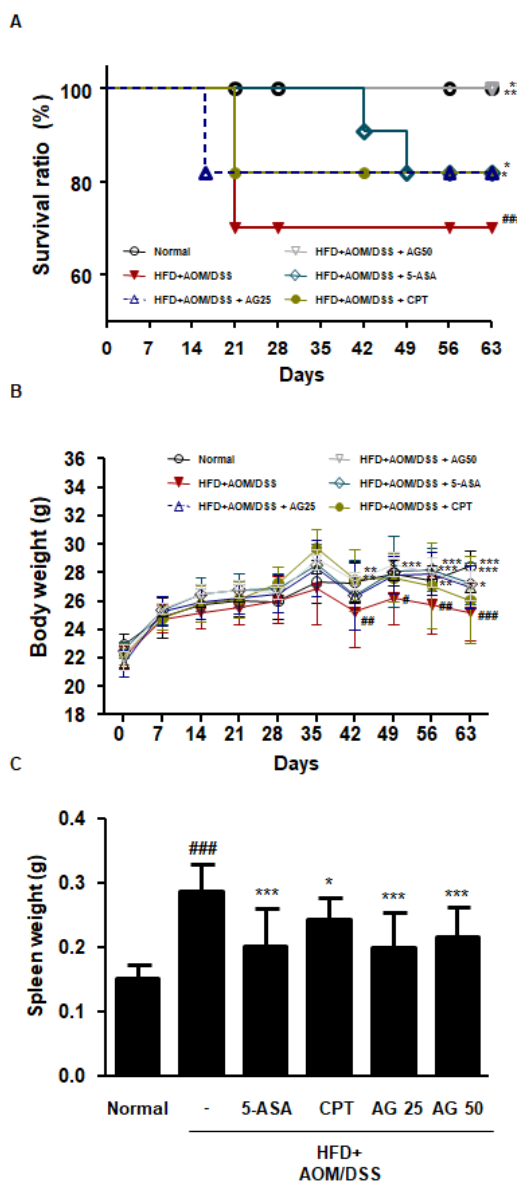
Figure 3. E ff ects of AG on the pathological symptoms in the HFD-propelled CAC mice model. The animals were randomly divided into six groups: normal group, HFD + AOM / DSS group (AOM / DSS-induced CAC mice fed HFD), 5-ASA group (CAC-induced mice fed on a HFD which was administered with 5-ASA 75 mg / kg daily, p.o.), CPT group (CAC-induced mice fed on a HFD which was administered with CPT 0.5 mg / kg daily, i.p.), and AG 25 and 50 group (CAC-induced mice fed on a HFD which was administered with AG 25 and 50 mg / kg daily, p.o.). ( A ) The survival ratio, ( B ) body weight, and ( C ) splenic weight were measured in each mouse. The values are the mean ± SD ( n = 10); ## p < 0.01, ### p < 0.001 vs. normal group; * p < 0.05, ** p < 0.01, *** p < 0.001 vs. the HFD + AOM / DSS group; significant di ff erences between the treated groups were determined by ANOVA and Dunnett’s post-hoc test.